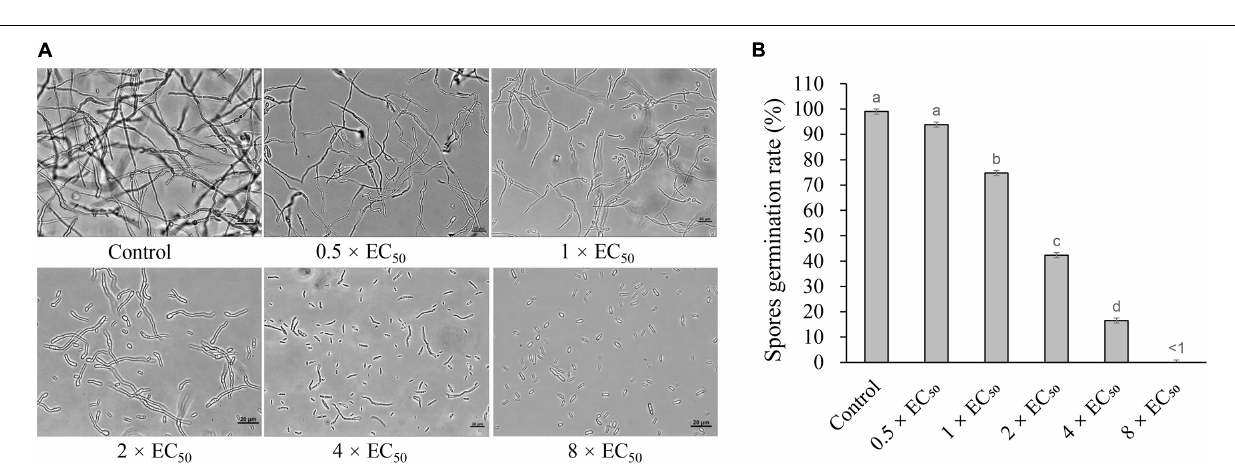
FIGURE 6 | Inhibition of strain H3-2 extracts on spore germination of Foc TR4. (A) Spore germination characteristics of Foc TR4 after treatment with 0.5 × , 1 × , 2 × , 4 × or 8 × EC 50 extracts. 10% of DMSO was used as a control. Bar = 20 µ m. (B) The spore germination rate (%) of Foc TR4 after treatment with different dose extracts. Different lowercase letters indicate a significant difference according to the Duncan’s multiple range test ( p <